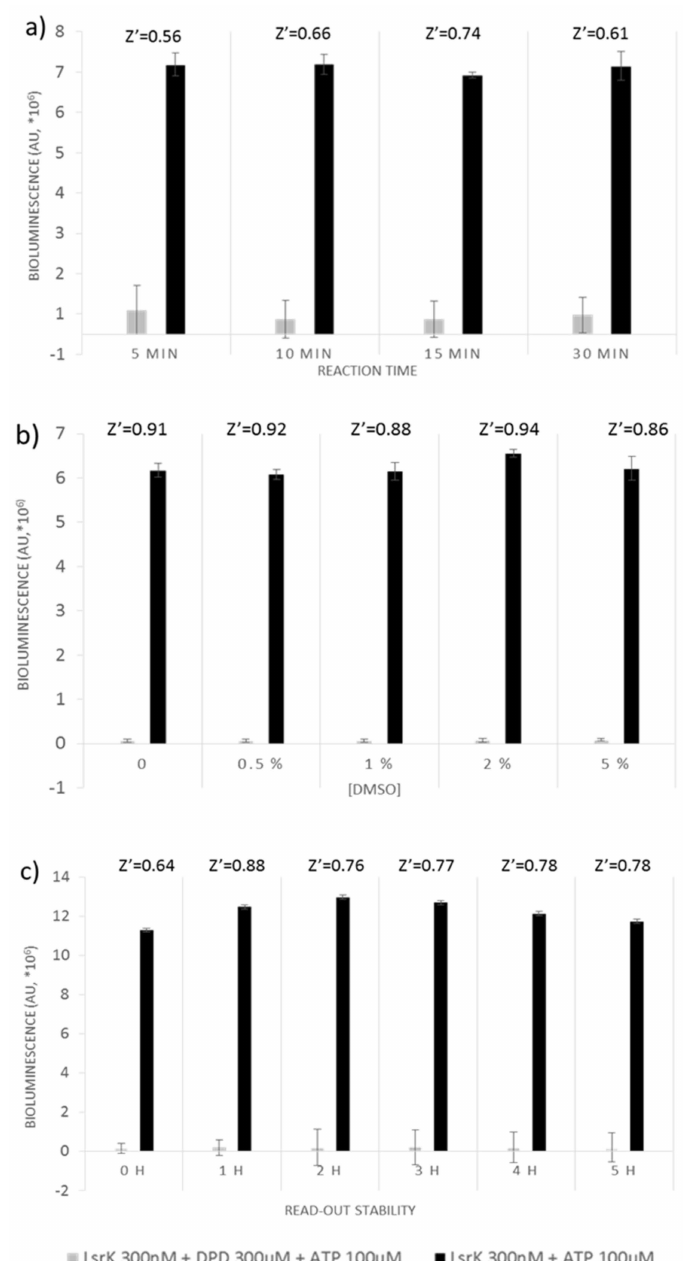
Figure 1. Optimization of LsrK high-throughput screening assay based on the Kinase-Glo Max Luminescentkinase kit: ( a )e ff ectof di ff erentincubationtimes; ( b )e ff ectof di ff erentDMSOconcentration; ( c ) evaluation of the stability of the read-out within a time window of 5